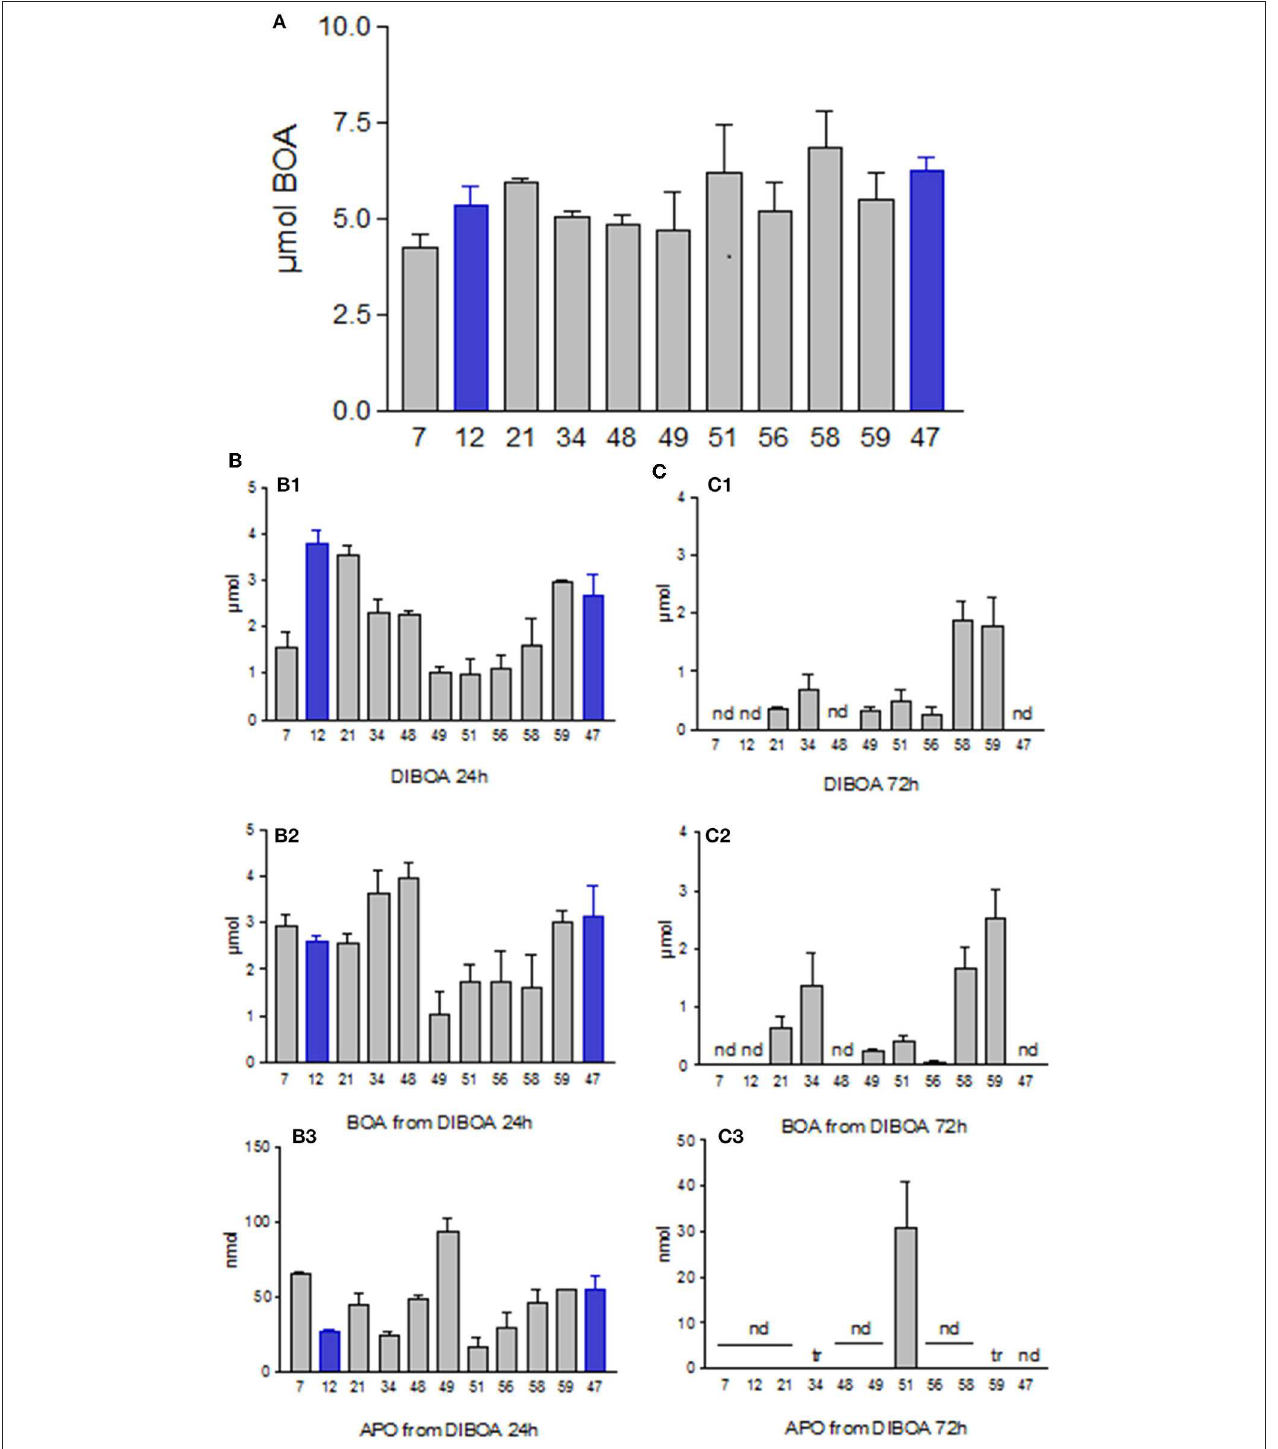
FIGURE 3 | (A) Amounts of BOA recovered from the culture media after 72h of incubation with 7.5 µ mol. (B,C) Incubations with DIBOA. (B1) DIBOA recovered from media after 24h. (C1) after 72h. (B2) amounts of BOA produced from DIBOA after 24h. (C2) after 72h. (B3) amounts of APO produced from DIBOA after 24h. (C3) after 72h. Nd, not detectable; tr, traces. Microorganisms: Mycobacterium fortuitum (7), Bacillus aryabhattai (34), Bacillus cereus (59), Bacillus megaterium (21, 48), Bacillus methylotrophicus (58), Lysinibacillus xylanilyticus (56), Paenibacillus polymyxa (51), Aminobacter aminovorans (49), the fungi Papulaspora sepedonioides (12), and Trichoderma viride (47) . Blue bars, fungi; gray bars, bacteria.